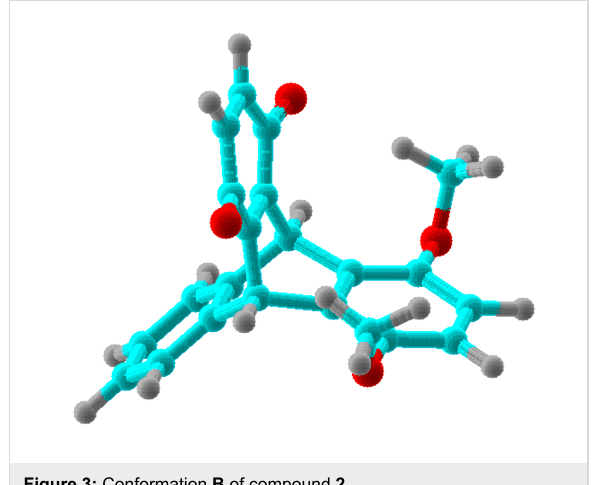
Figure 3: Conformation B of compound 2 .